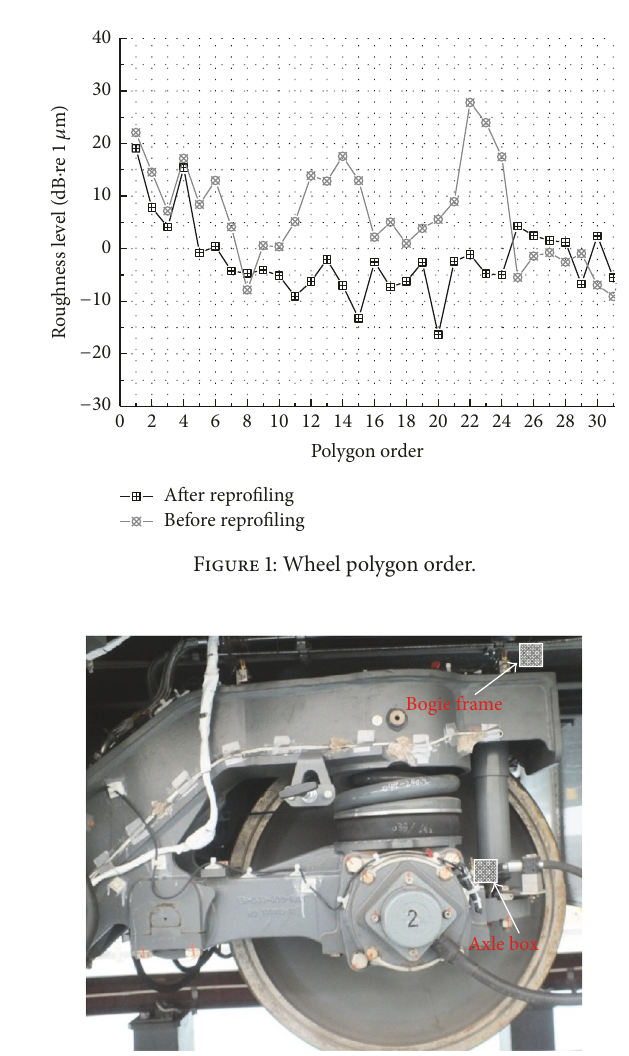
Figure 2: Test photo of accelerations installed on the bogie frame and axle